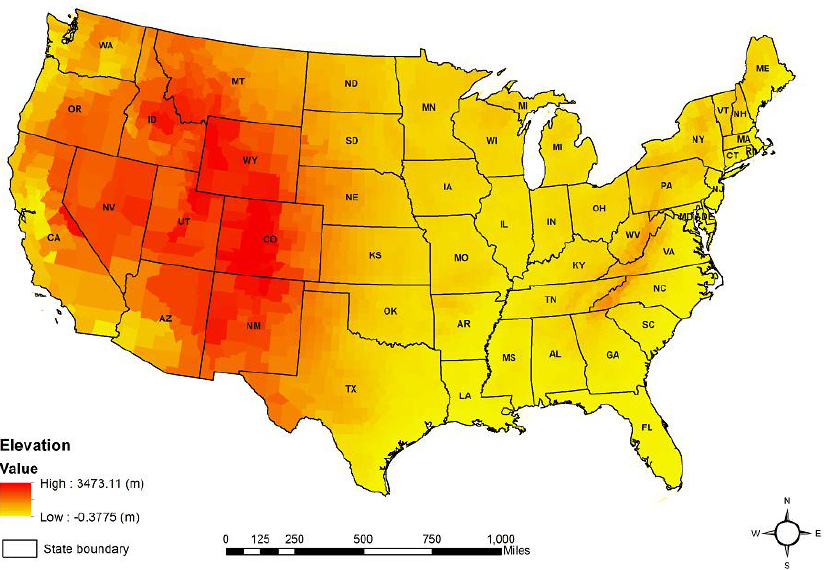
Figure 2. Mean county altitude in the 48 contiguous U.S. states.